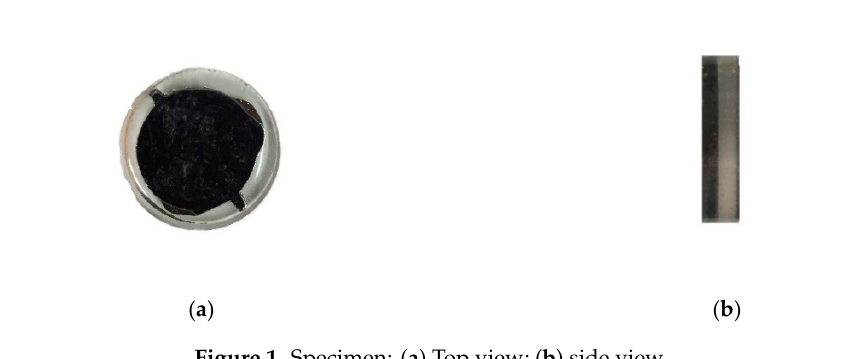
Figure 2. Specimens: ( a ) HRB500; ( b ) novel type-2205 duplex stainless steel.